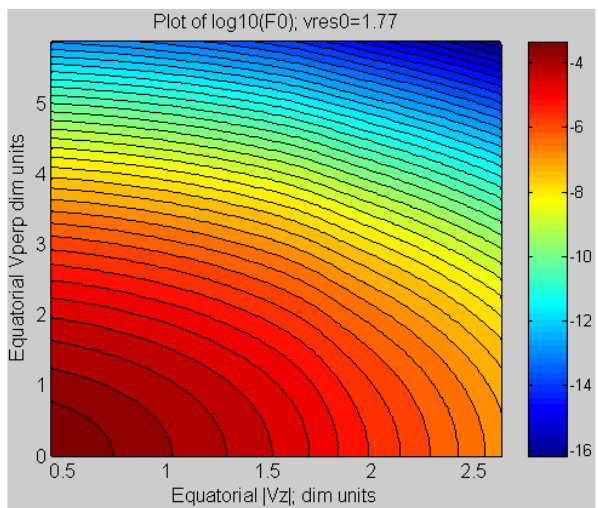
Fig. 4. Fig. 4. Contour plots of log 10 (F0) in equatorial parallel vs. perpen-